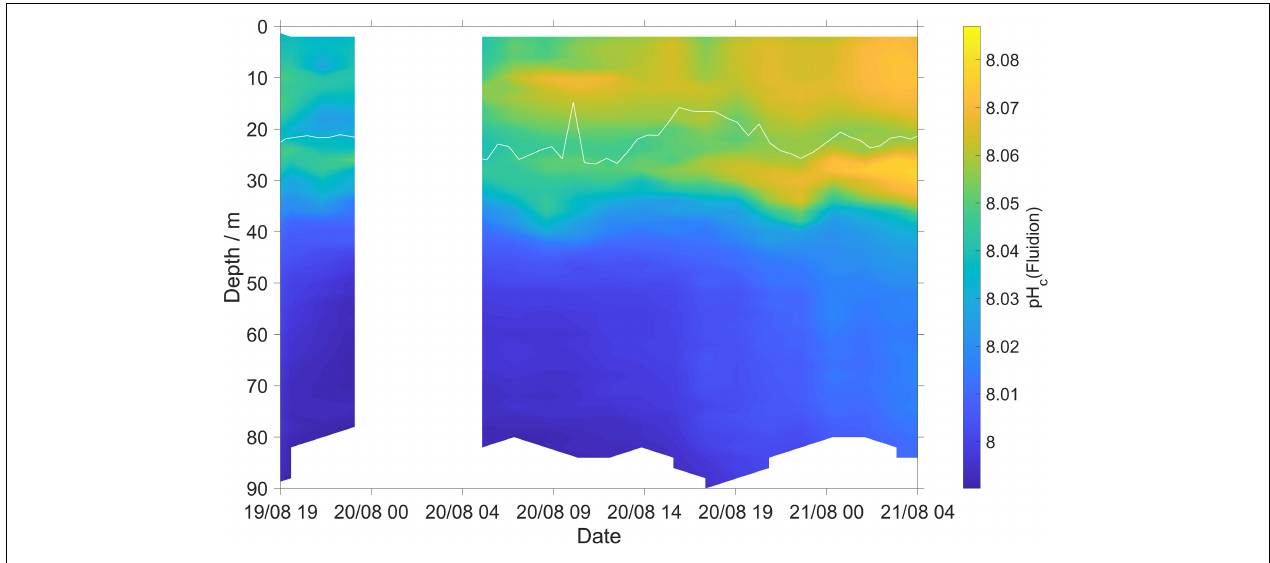
FIGURE 7 | Thermal-lag corrected and calibrated Fluidion pH sensor measurements (Eq. 3). White line: surface mixed layer depth ( z mix